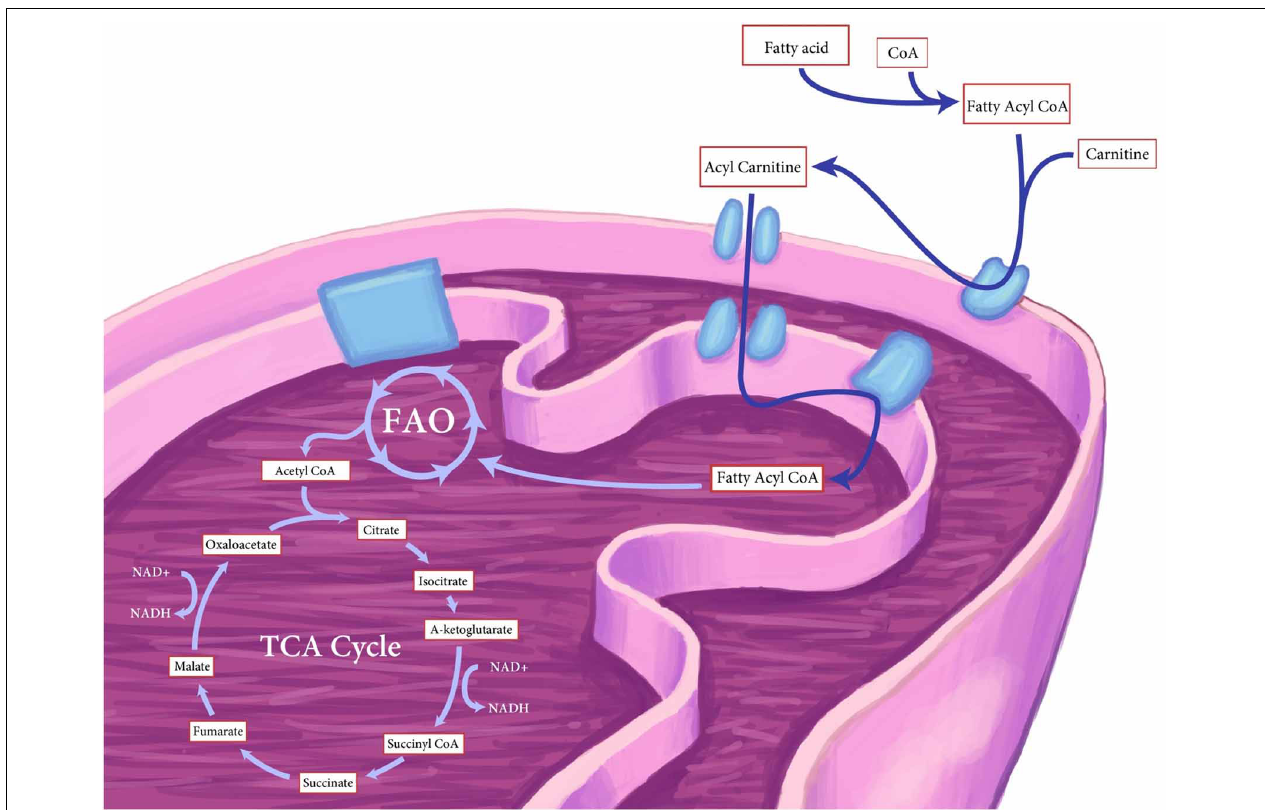
FIGURE 1 | Schematic of the process of fatty-acid oxidation (FAO) in cells. Fatty-acid-CoA (FA-CoA) is converted to an acyl carnitine derivative in the mitochondrial membrane, acylcarnitine is then converted back to FA-CoA within the mitochondria where it undergoes